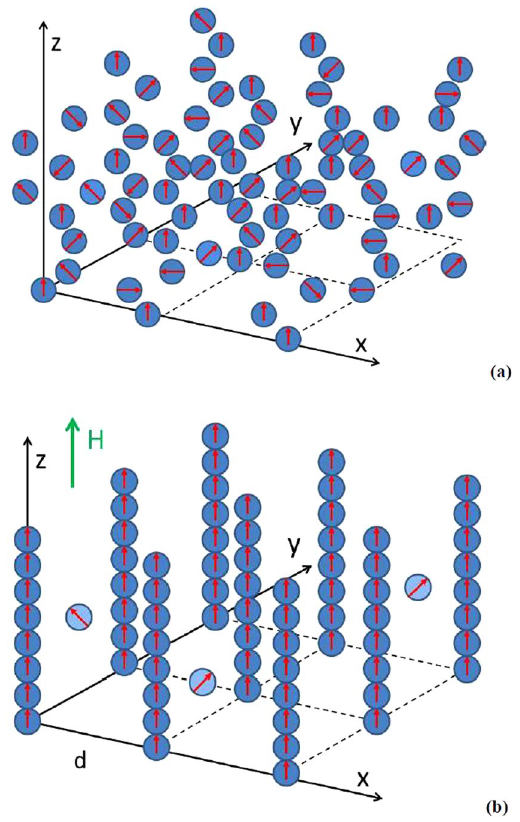
Figure 1. Schematic geometry of the ferrofluid before ( a ) and after ( b ) application of external magnetic field. Before the field is applied, the “optical spacetime” in the ferrofluid has Euclidean character. Alignment